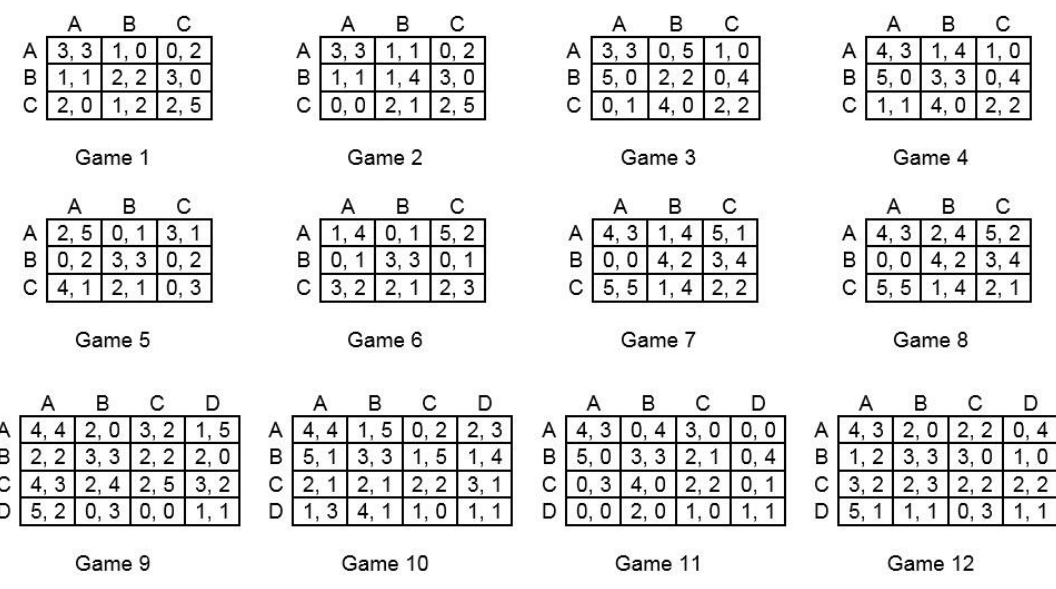
Figure 1. Experimental games, with labels for Player 1 (row chooser) and Player 2 (column chooser) omitted to save space.